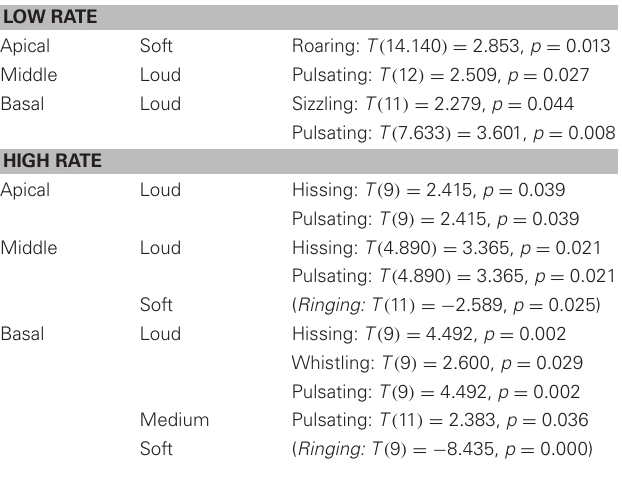
Table 4 | Effectiveness of sound stimuli by tinnitus